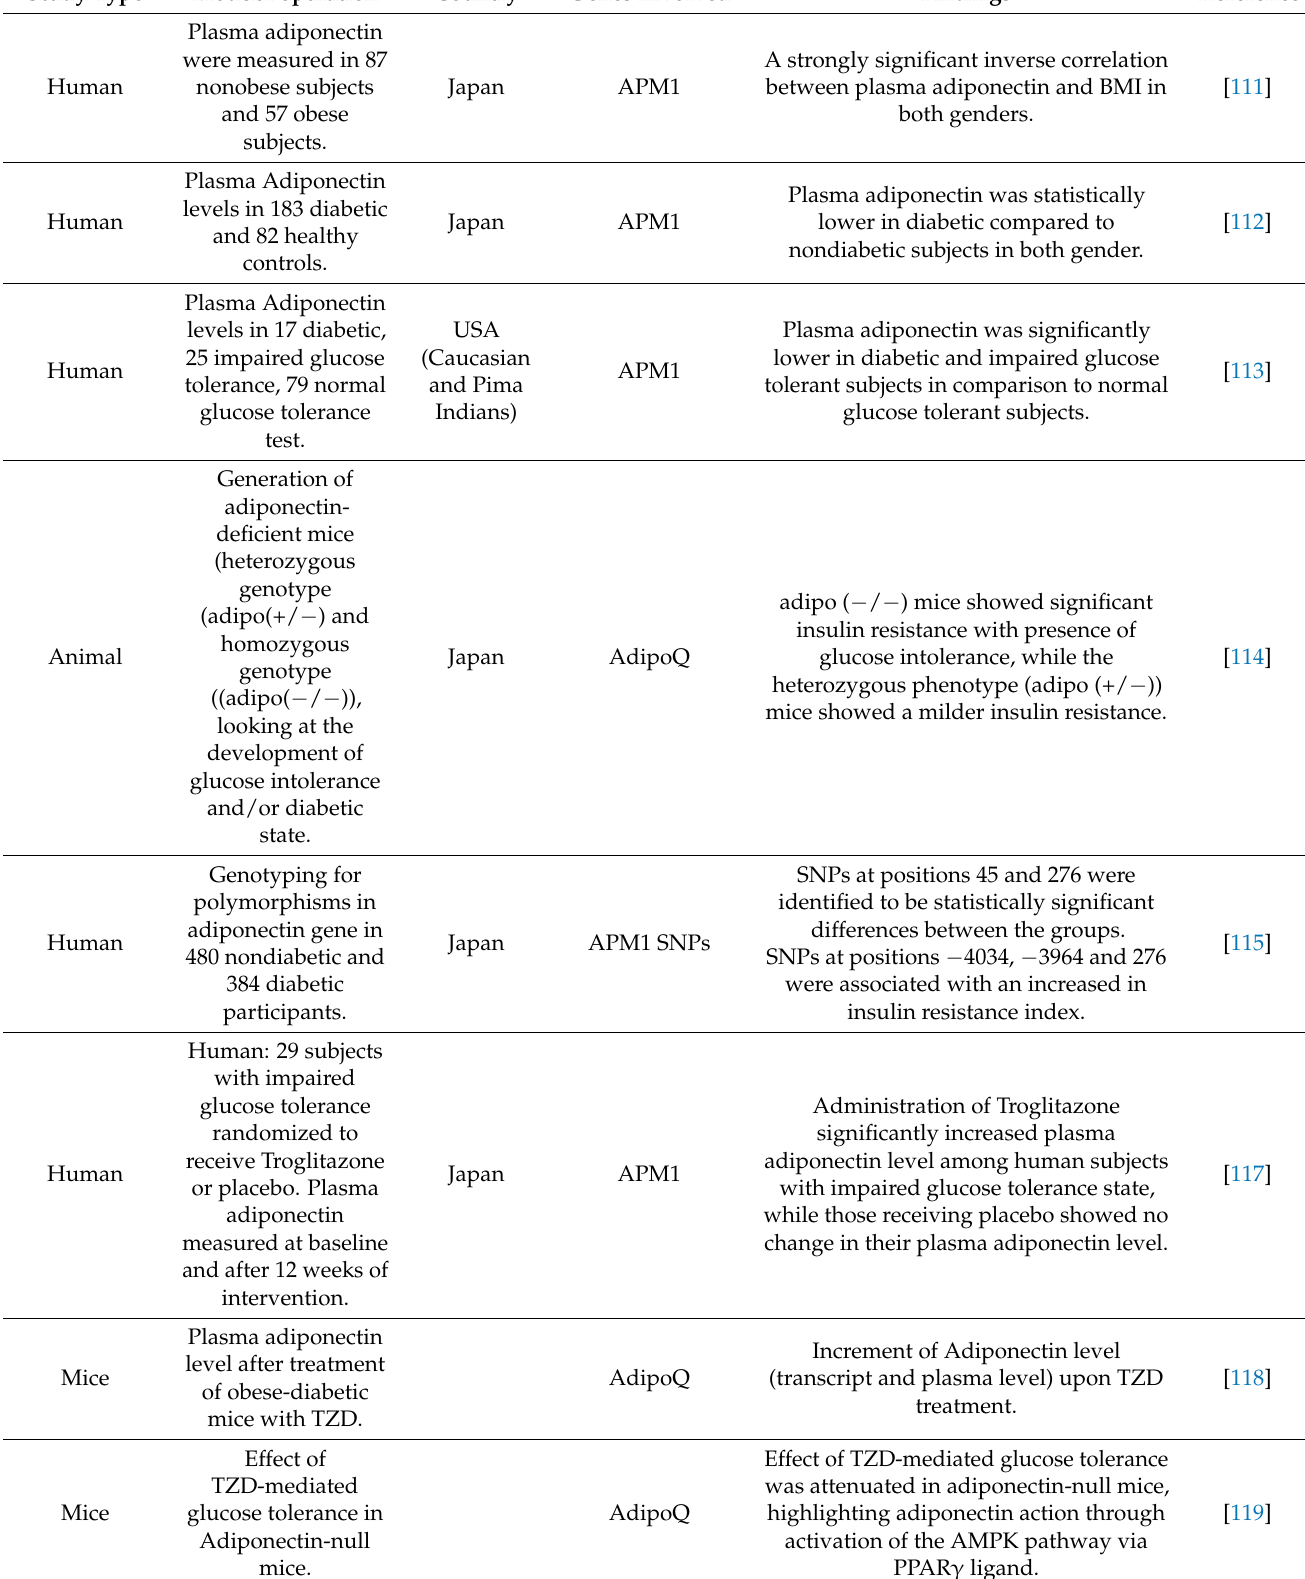
Table 6. The relationship between adiponectin gene and its polymorphism with